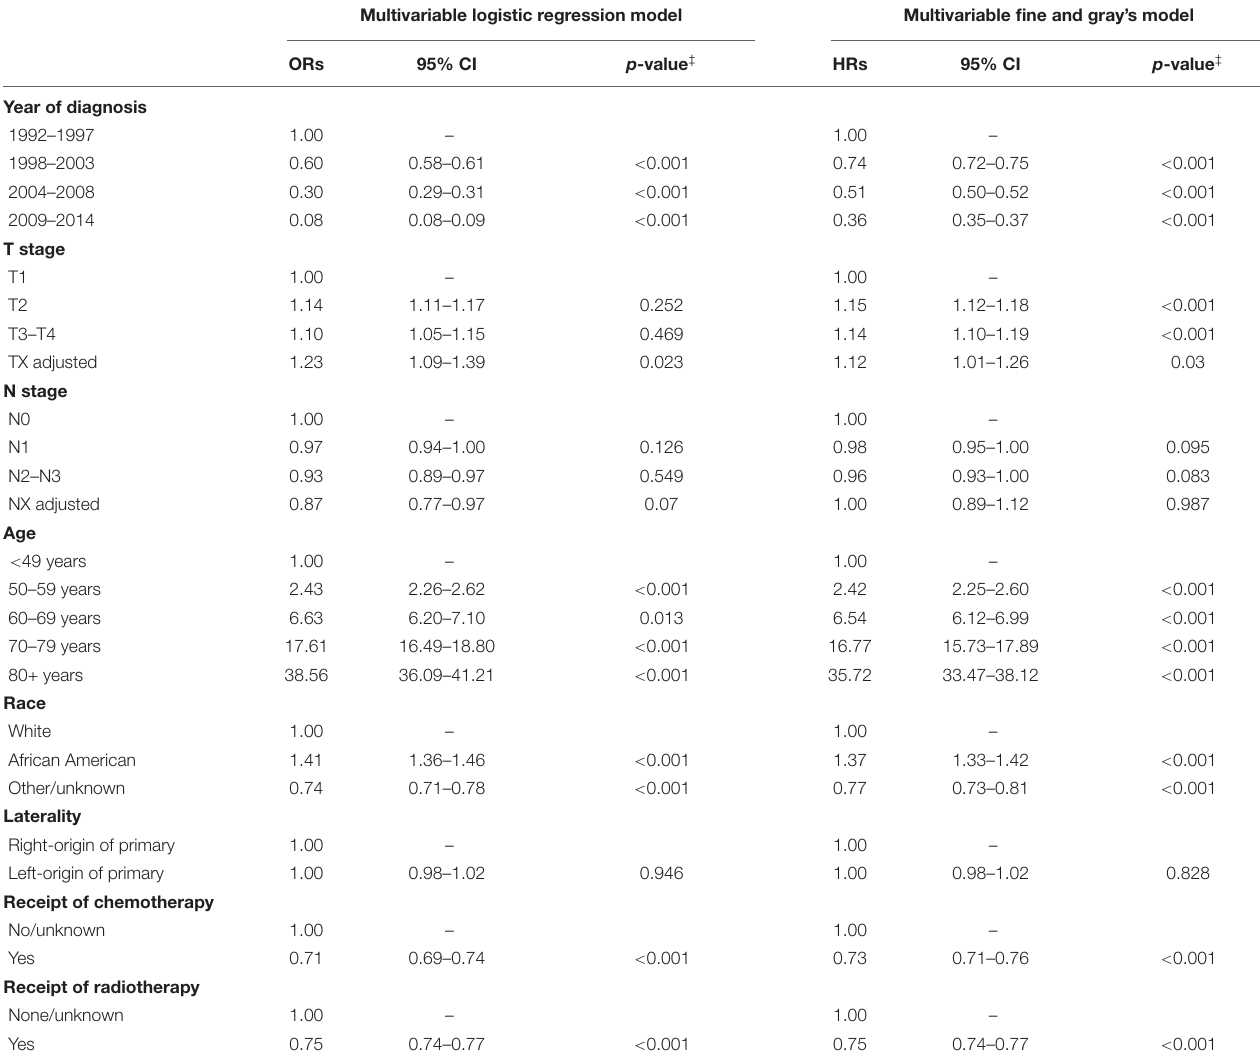
TABLE 2 | Odds ratios and hazard ratios of fatal heart disease among cancer patients. Multivariable logistic regression model Multivariable fine and gray’s